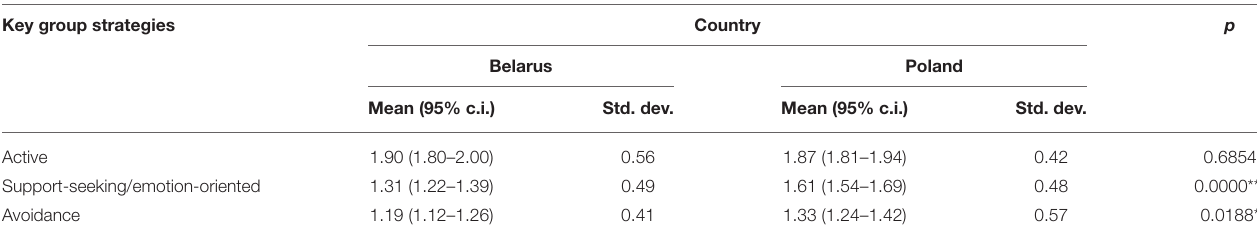
TABLE 3 | Descriptive statistics for key group stress coping strategies among nurses. Key group